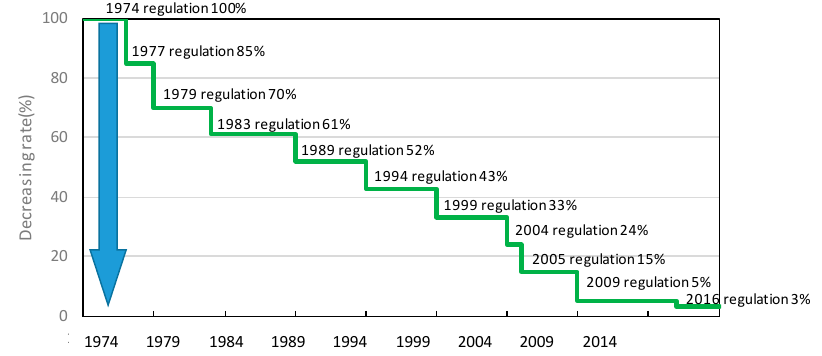
Figure A1. Timeline of NOx regulations for heavy diesel vehicles.